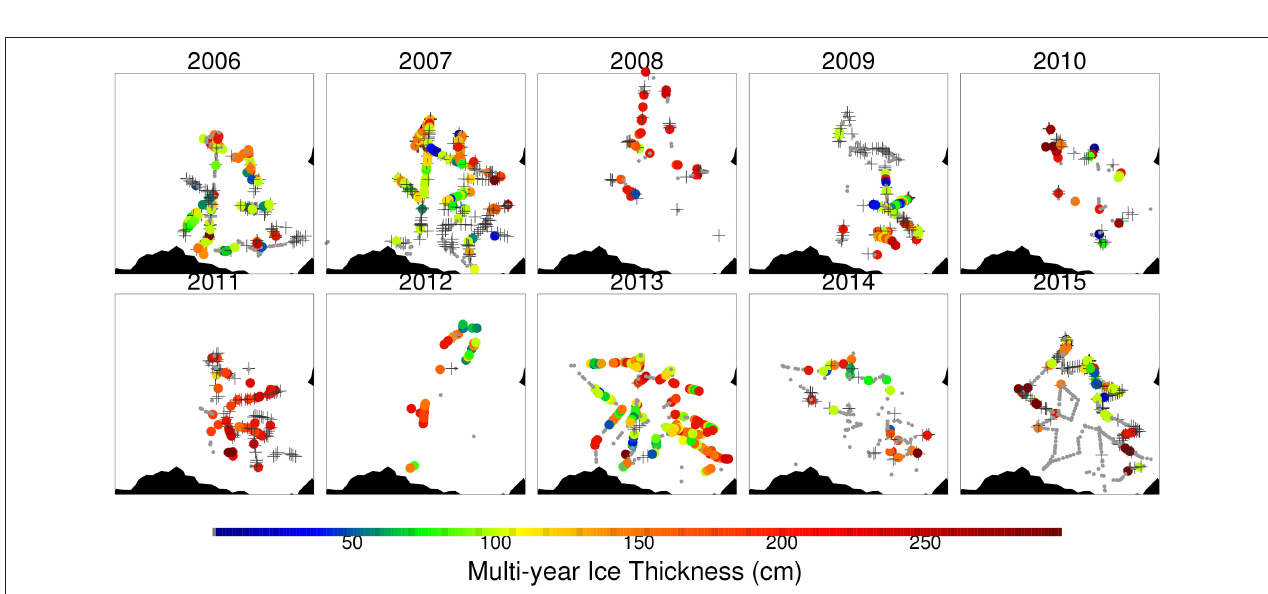
FIGURE 3 | First year ice thickness. Observations where no first year ice was present are shown as small gray circles. Crosses show where first year ice was observed but a thickness estimate not recorded.